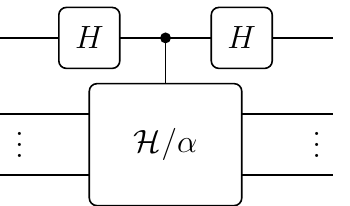
( H /α + I ) , the 2 /α , which may be λ